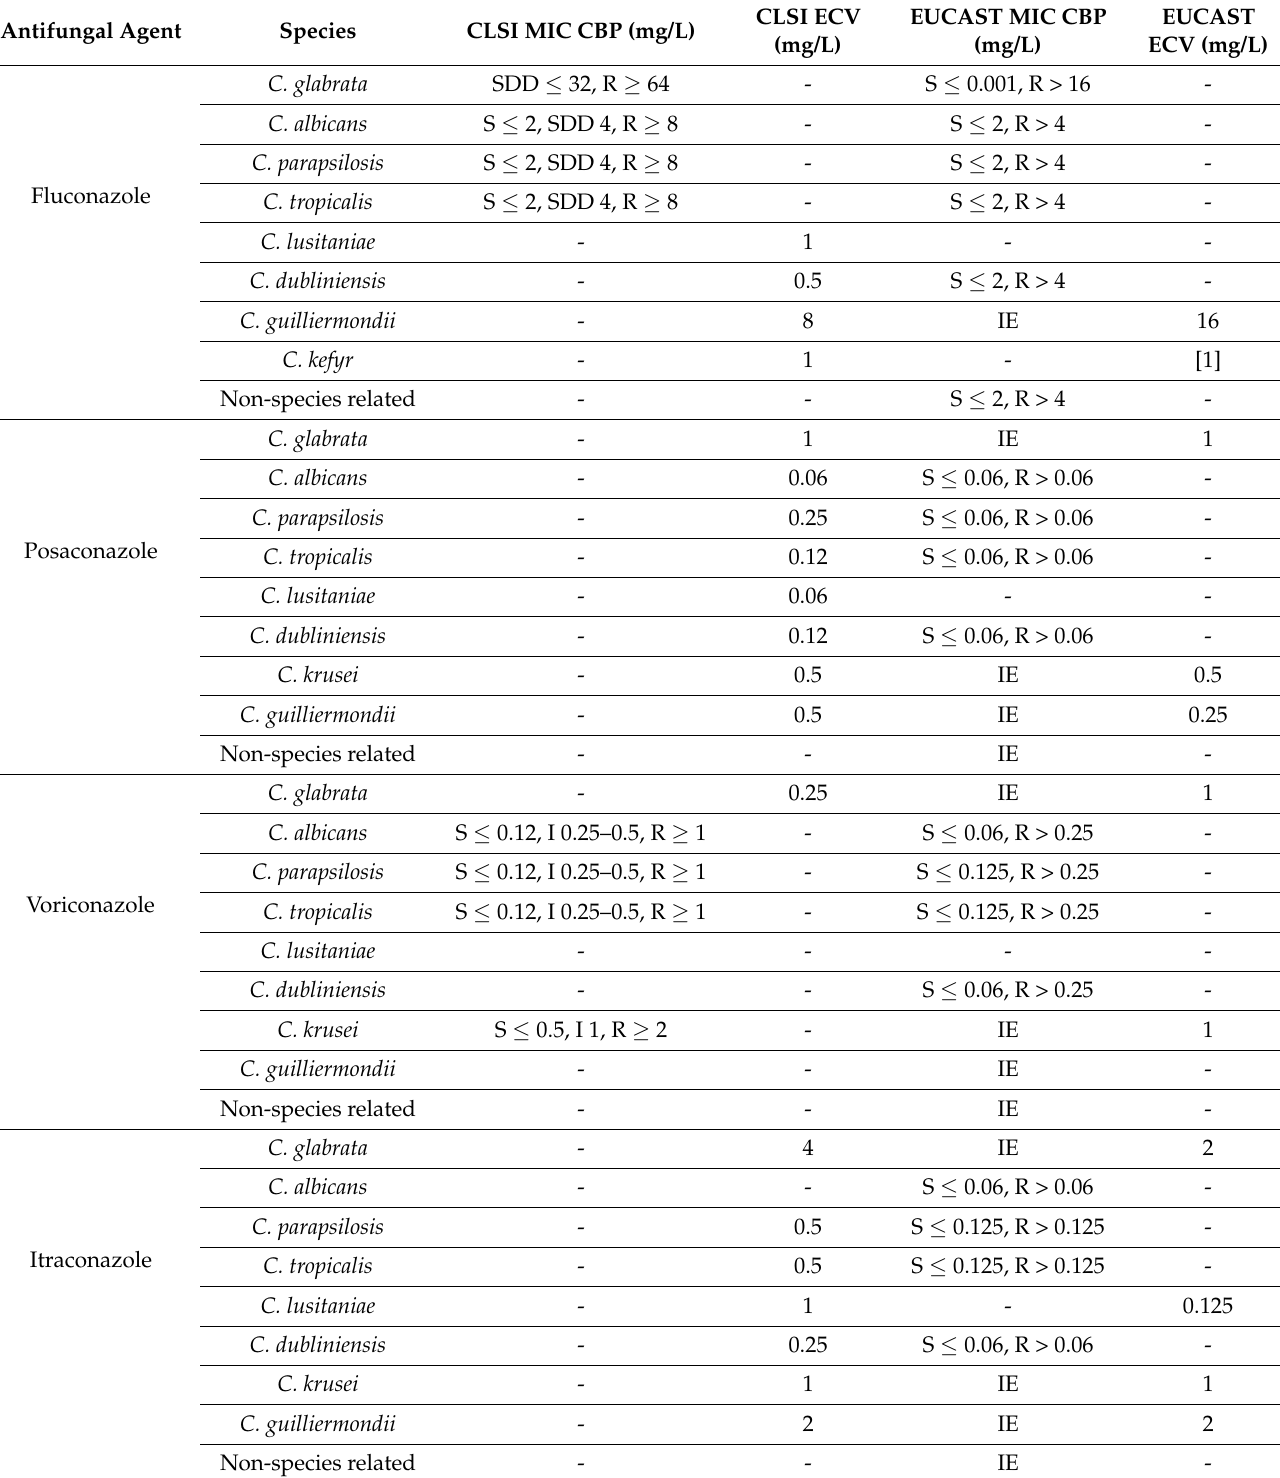
Table 1. Breakpoint table with CLSI and EUCAST CBPs and